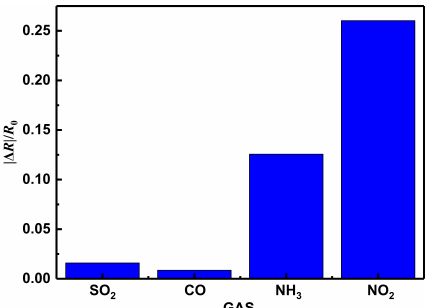
Figure 9. Selectivity of 5.1%RGO/SnO 2 sensor to 50 ppm SO 2 , CO, NH 3 , NO 2 .